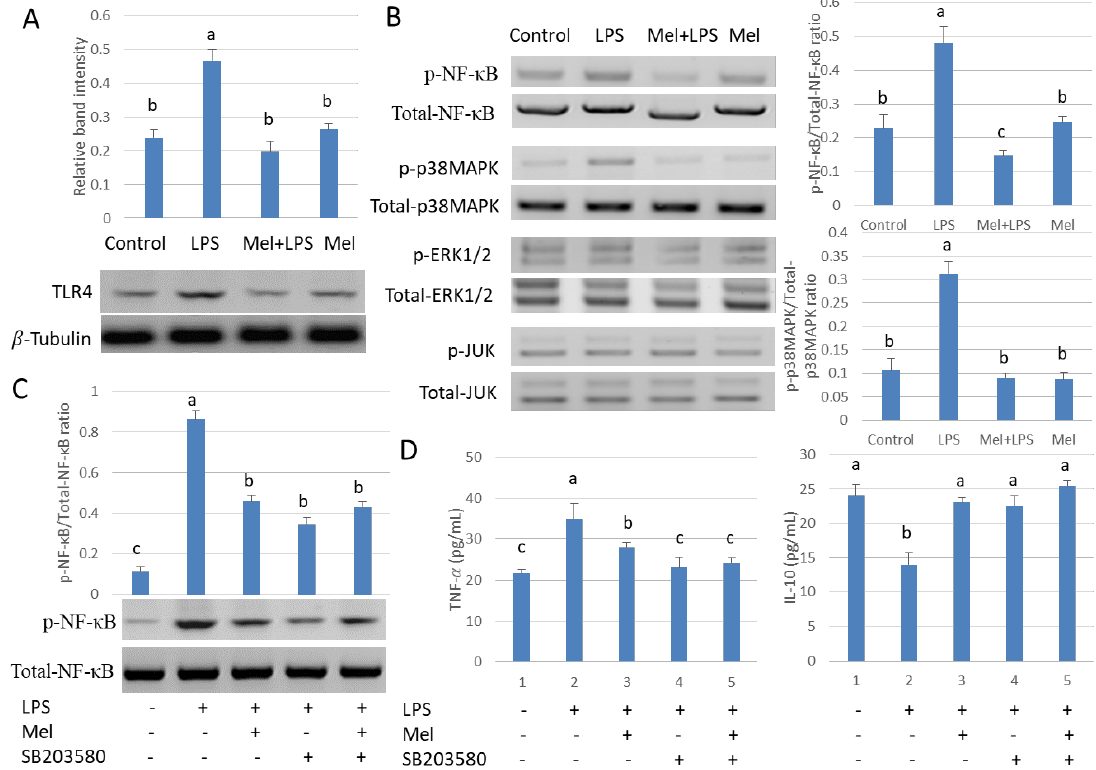
Figure 3. Melatonin regulates NF- 𝜅 B expression through the p38/MAPK signaling pathway in TM. Western blotting detection ( A ) expression of TLR4 and ( B ) p-p38MAPK/p38MAPK, p-JUN/JUN, p-ERK1/2/ERK1/2 and p-NF-кB/NF-кB. Four groups were used in this study: the control, LPS infection, Mel+LPS and Mel. ( C ) p-NF- 𝜅 B/NF- 𝜅 B expression Western Blotting detects. ( D ) TNF- 𝛼 and IL-10 protein expressions detected by ELISA. TM treated with LPS, Mel, and/or SB203580. Data are shown as mean ± SEM. Different superscript letters (a–c) in each column representative statistically significant differences ( p < 0.05).